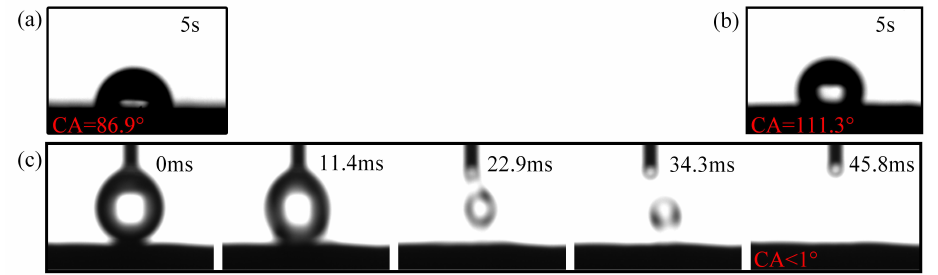
Figure 2. Contact angle measurement using 5 µ L of deionised water. ( a ) Copper plate; ( b ) Porous material; ( c ) Composite wick after wettability